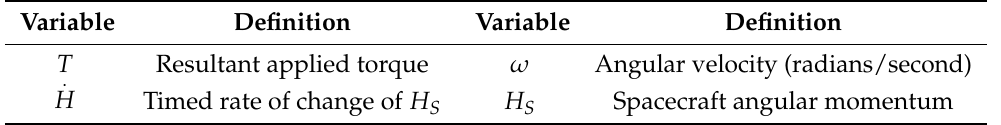
Table 1. Definitions of proximal variables for Section